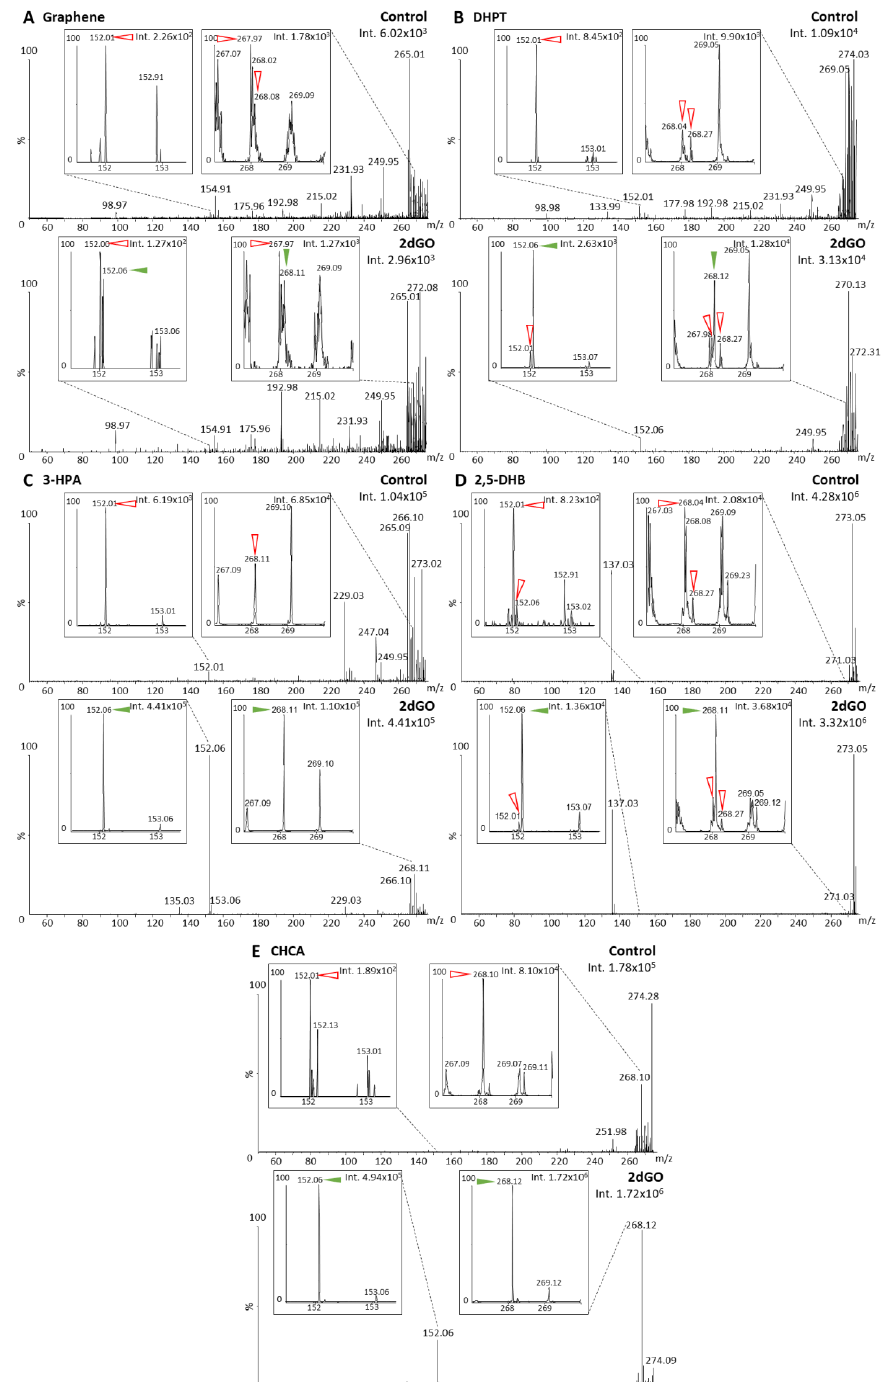
Figure 3. Matrix-assisted laser desorption/ionization (MALDI) mass spectra of solvent (control) and 2 (cid:48) -deoxyguanosine (2dGO) solution at 0.5 µ g/mL in MeOH/H 2 O 1:1 with zoomed views on the 2dGO parent peak at m/z 268.11 and its fragment peak at m/z 152.06. Spectra were obtained with graphene MALDI matrix ( A ), 2,3,4,5-tetrakis(3 (cid:48) ,4 (cid:48) -dihydroxylphenyl)thiophene (DHPT) ( B ), 3-hydroxypicolinic acid (3-HPA) ( C ), 2,5-dihydroxybenzoic acid (2,5-DHB) ( D ), and alpha-cyano-4- hydroxy-cinnamic acid (CHCA) ( E ). Spectra were acquired using method Q-268 (positive resolution mode, with quadrupole focused on m/z 268). Maximum intensities are given in arbitrary units (a.u.) on the top right corner of each spectrum and zoomed view. Peaks from the MALDI matrices are marked with red open arrows and peaks from 2dGO with green solid